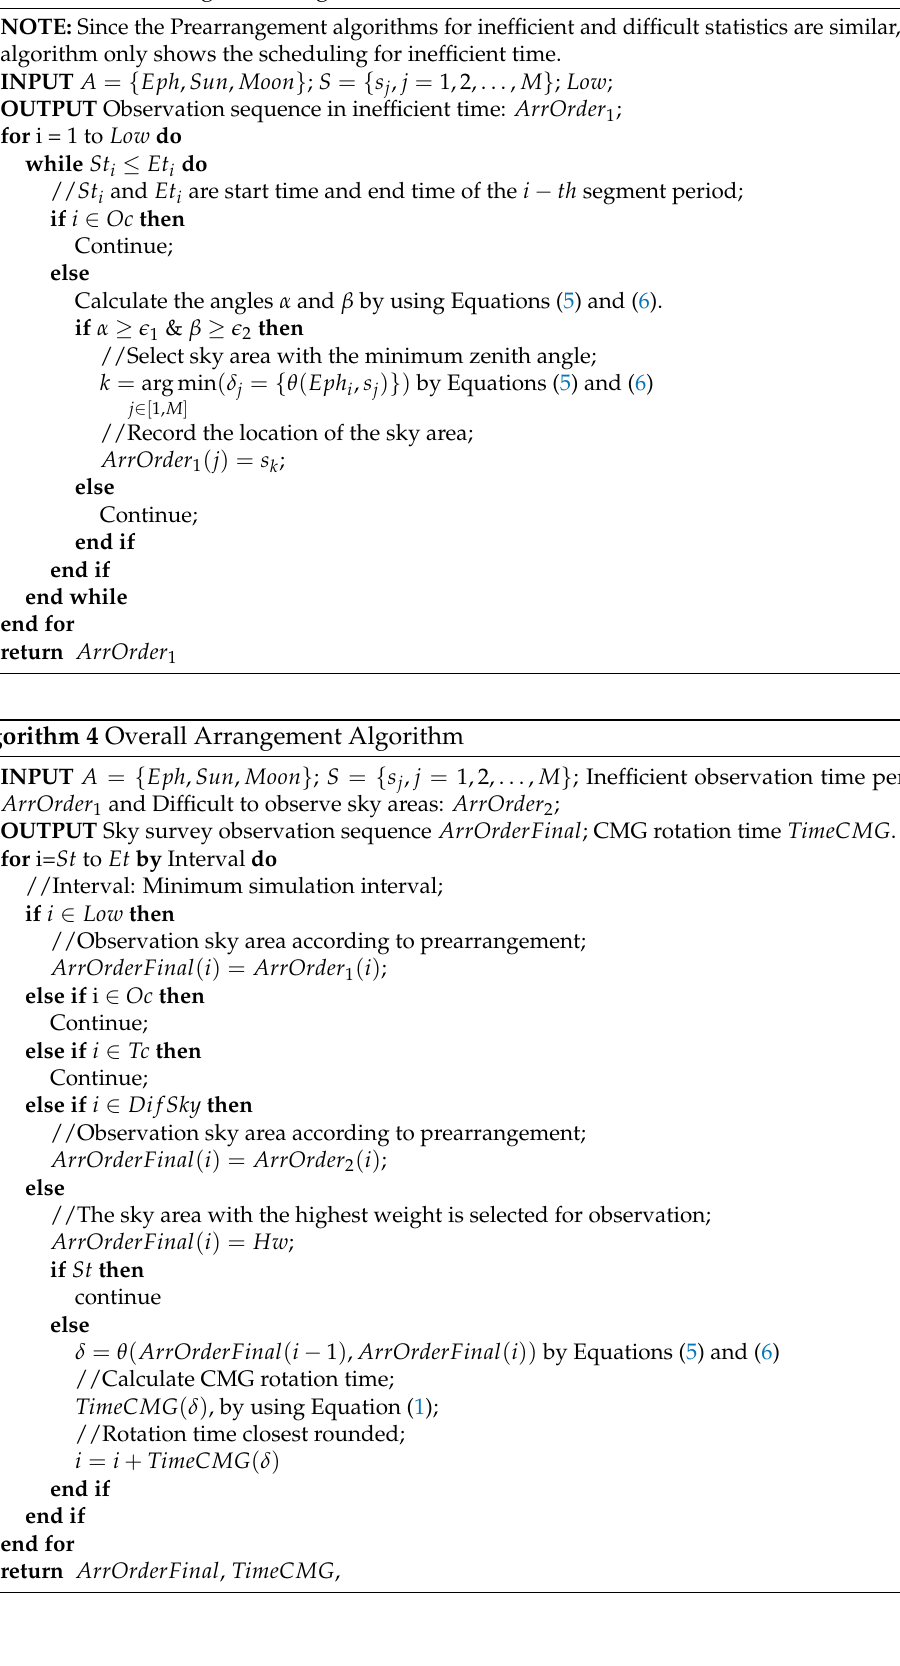
Algorithm 3 Prearrangement Algorithm